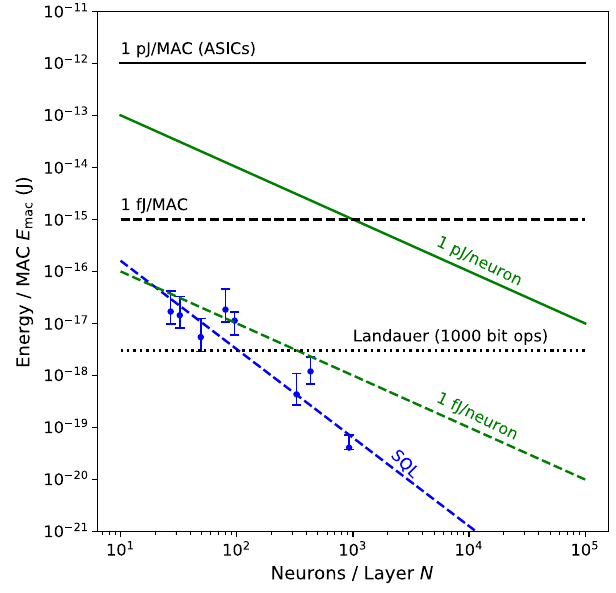
FIG. 4. (a) Conventional picture. Error rate as a function of number of MACs for different fully connected MNIST neural networks. (b) SQL picture. Error rate as a function of total number of photons, for the same networks.